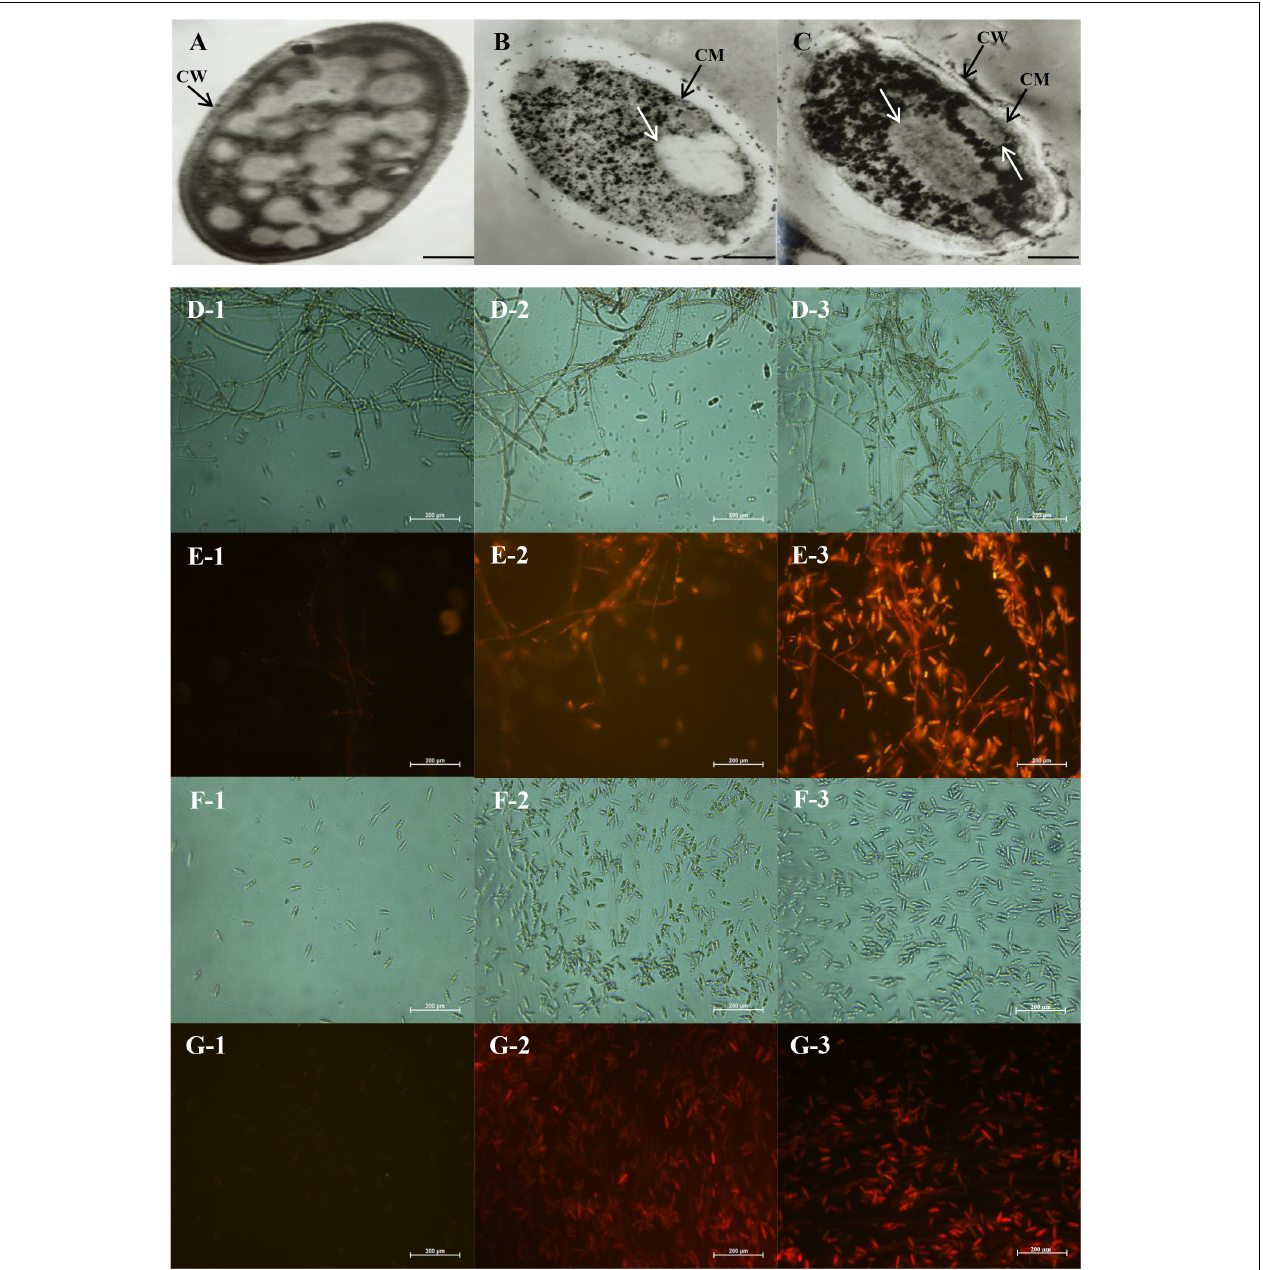
FIGURE 3 | Transmission electron microscopy (A–C) and fluorescence microscopy images (D–G) of antifungal effect of CEO against C. acutatum . (A) Healthy mycelia with control, the magnitudes of 15000 × ; (B) Mycelia treated with the MFC of CEO; (C) Mycelia treated with the 2MFC of CEO; (D1–D3) Bright field of mycelia in microscopy after 0, 3, and 6 days of incubation, in the magnitudes of 400 × ; (E1–E3) Propidium iodide of mycelia in microscopy after 0, 3, and 6 days of incubation; (F1–F3) Bright field of spores in microscopy after 0, 3, and 6 days of incubation; (G1–G3) Propidium iodide of spores in microscopy after 0, 3, and 6 days of